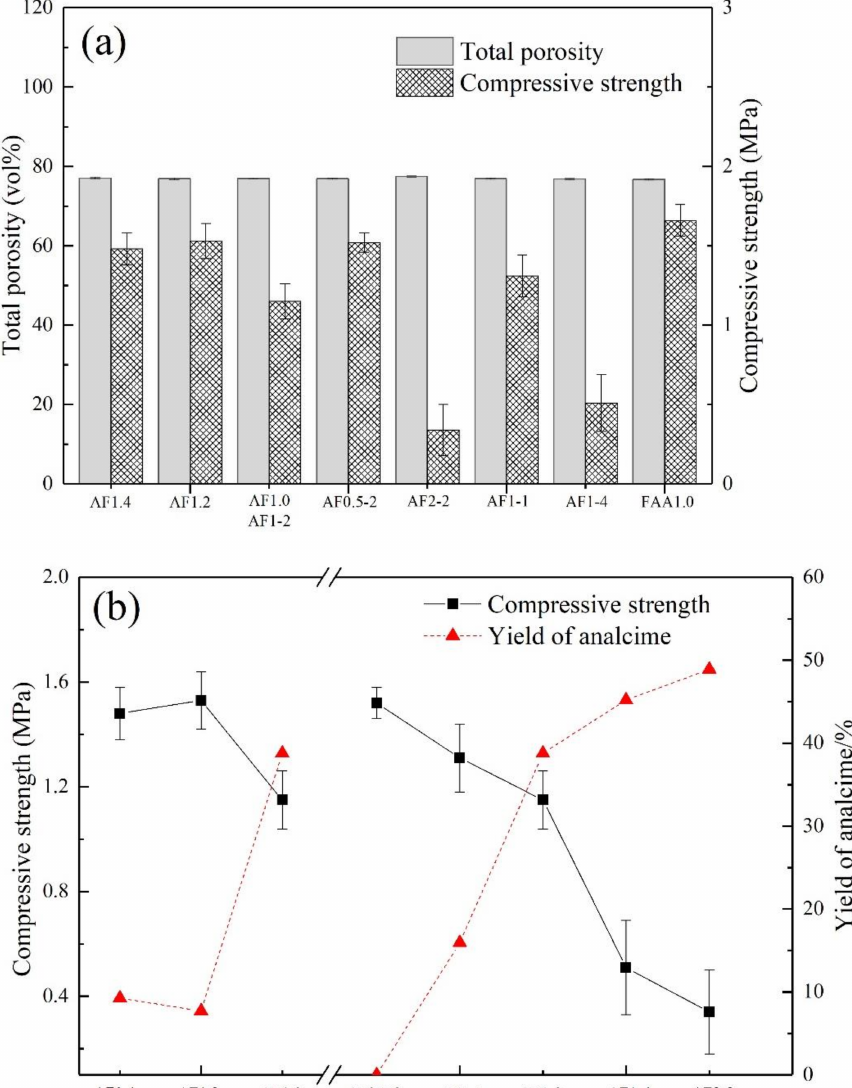
Figure 5. ( a ) Total porosity, compressive strength, and ( b ) zeolite yield results of